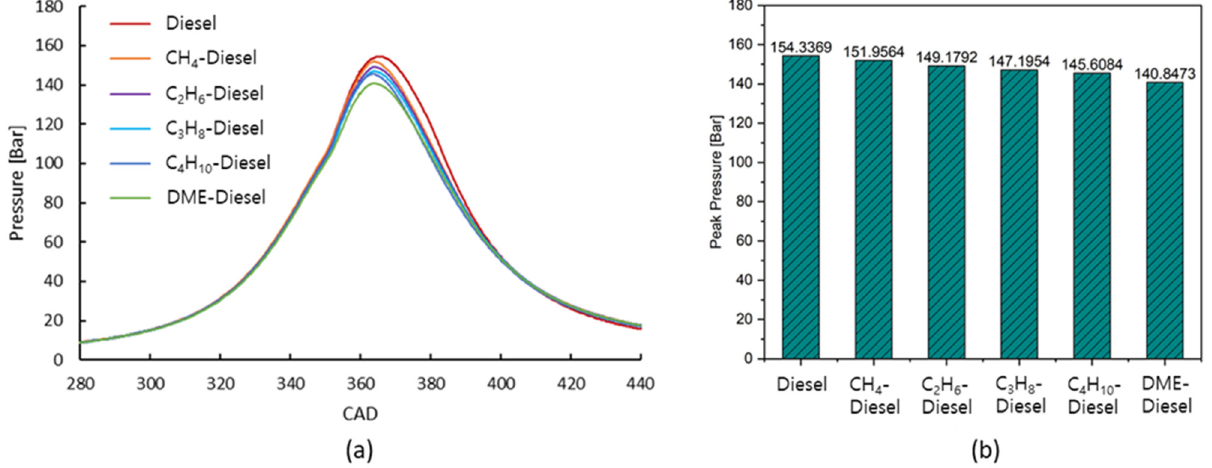
Figure 10. The mean in-cylinder pressure diagrams ( a ) and maximum in-cylinder pressure ( b ) in all operating modes